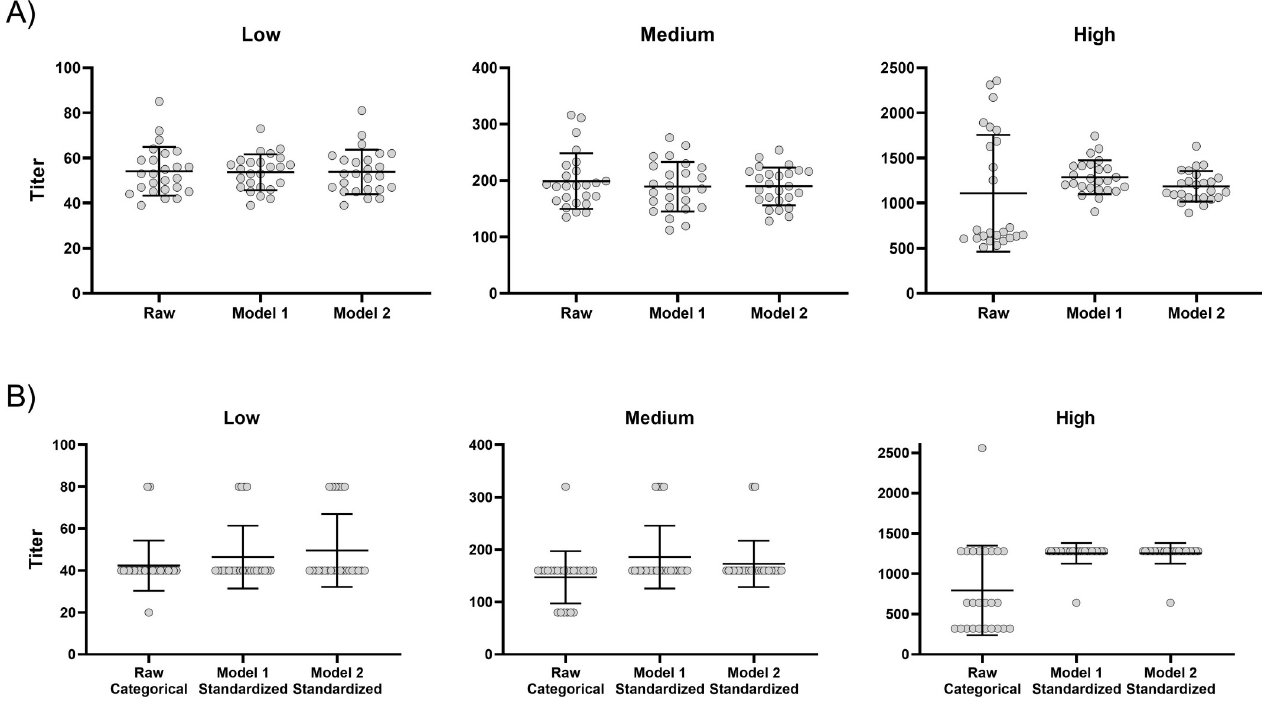
Fig 4. Distribution of raw and normalized results from a precision study. Scatterplots of exact titers (A) and categorical/ standardized titers (B) from replicate determinations in the low, medium and high titered sample groups from raw data, data normalized using model 1 and data normalized using model 2. Bars represent global mean and standard deviation. Exact titer = titer calculated according to a four-parameter logistic regression curve fit from non- normalized (raw data) or normalized OD-values; Categorical titer = the highest serum dilution positive for neutralization activity determined from non- normalized OD-values (raw data); Standardized titer = the closest standard dilution factor on a log 2 scale starting from a 1:10 dilution calculated from normalized OD-values. Virus: early pandemic strain (lineage B.1). For all precision study experiments, ELISA primary antibody: rabbit mAb 40143-R019.